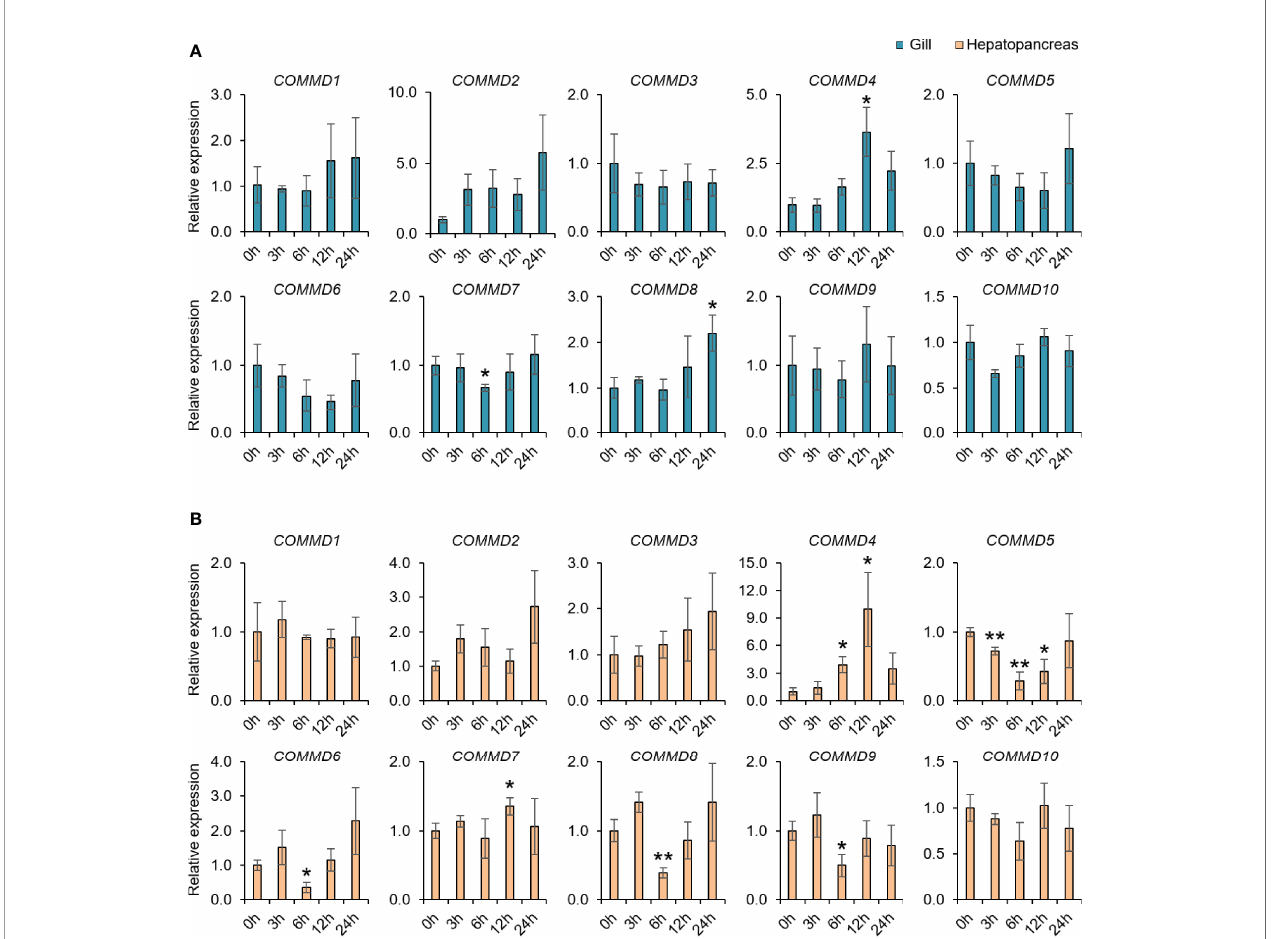
FIGURE 7 | Relative COMMD genes expression in M. lateralis gill and hepatopancreas after V. anguillarum infection. (A) Relative expression of MLCOMMDs in gill after V. anguillarum infection. (B) Relative expression of MLCOMMDs in hepatopancreas after V. anguillarum infection. The relative fold changes compared with control group for each test point are shown as a bar chart (signi fi cance: ** p < 0.01; * p < 0.05). The blue boxes indicate gill and the light orange boxes indicate